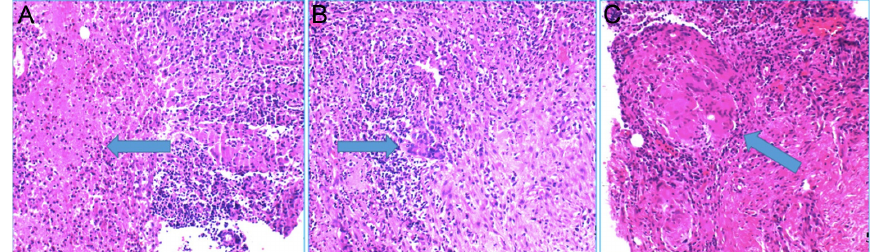
Figure 4. A-C. Images from A to C (blue arrows, H&E × 200 magnification) depict granuloma tissues on core-biopsy specimens.